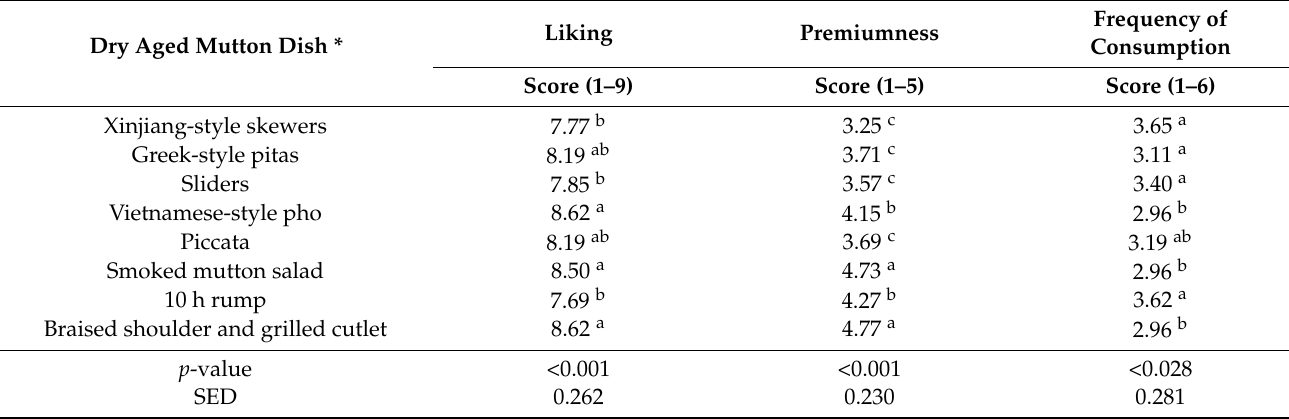
Table 6. Mean liking, premiumness and frequency of consumption ratings for dry aged mutton dishes. Level of significance ( p -value) and standard error of differences (SED).